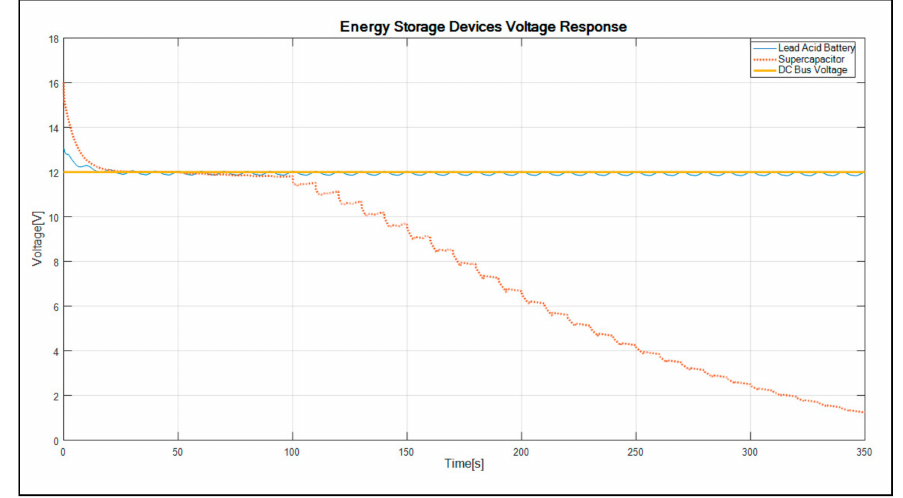
Figure 9. LAB and supercapacitor voltage